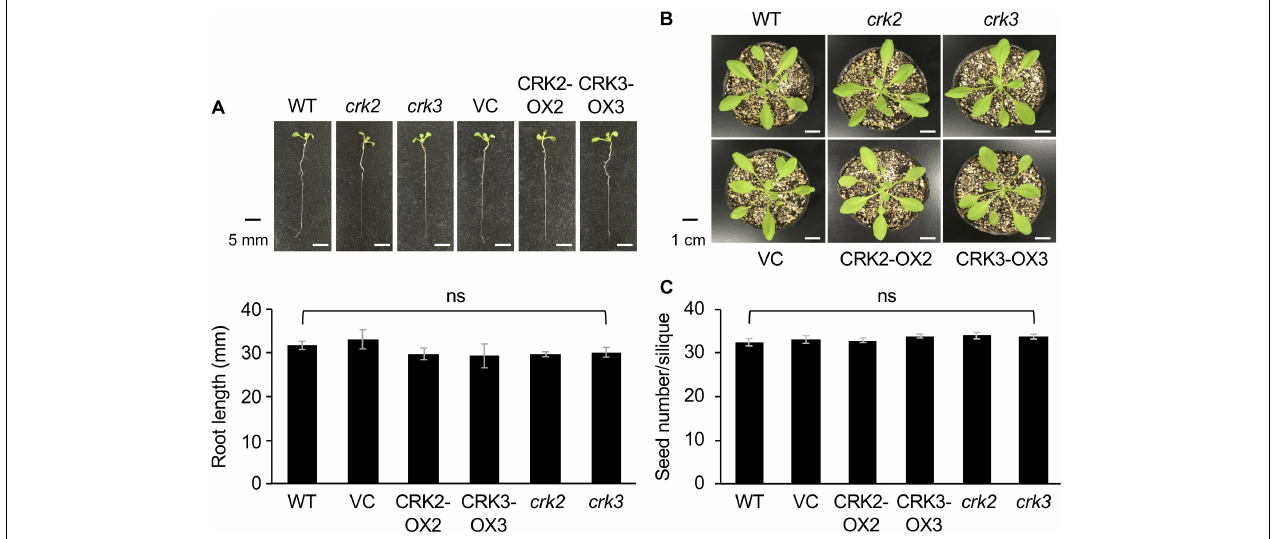
FIGURE 4 | The phenotype and root length of seedlings (A) and rosette plants (B) , and the numbers of seeds (C) of wild type (WT), crk2 , and crk3 mutants, CRK-overexpressing lines (CRK2-OX2 and CRK3-OX3), and their VC line. Plant seedlings were grown on medium for 14 days, and rosette plants and plants during the harvest time were grown on soil for 4 weeks and ∼ 8 weeks, respectively. Means and standard errors of root lengths were determined using 12 individual seedlings. Means and standard errors of the numbers of seeds were determined using five pods from eight individual plants. ns, not significant based on a one-way